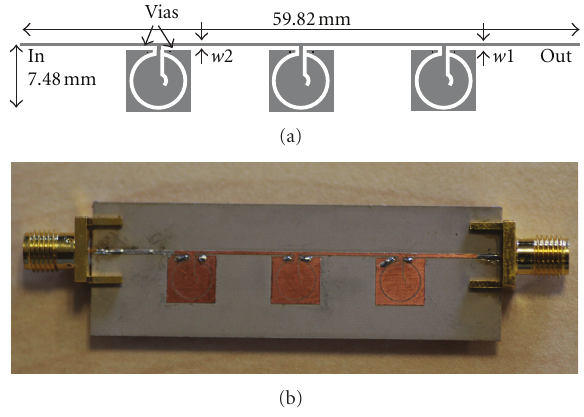
Figure 4: Topology (a) and photograph (b) of the proposed Figure 6: Topology (a) and photograph (b) of the proposed bandpass filter of the first example. The substrate is the Rogers bandpass filter of the second example. The substrate is the Rogers RO3010 with thickness h = 0 . 254 mm and dielectric constant RO3010 with thickness h = 0 . 635 mm and dielectric constant ε r = . 2. For the OCSRRs, r ε = 2 . 7 mm, c = 0 . 37 mm, and r = 10 ext 10 . 2. For the OCSRRs, r ext = 3mm, c = 0 . 16mm, and d = 2 mm. d = 1 . 63 mm. The width of the transmission line inverters is w 1 = The width of the transmission line inverters is w 1 = 0 . 503 mm for 0 . 33mm for the external ones and w 2 = 0 . 28 mm for the internal the external ones and w 2 = 0 . 335 mm for the internal ones.